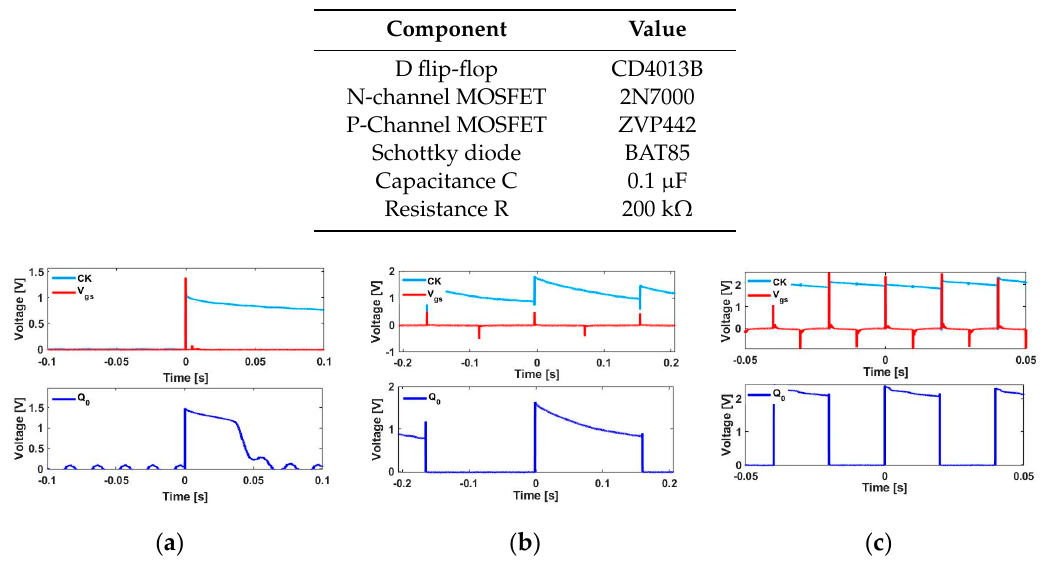
Figure 8. Experimental waveforms of the single-bit counter at various excitation frequencies using an active rectifier. Output Q 0 , CK (clock signal), and V gs of single-bit D flip-flops (CD4013B) for ( a ) a single rotation and at excitation frequencies of ( b ) 5 and ( c ) 50 Hz.